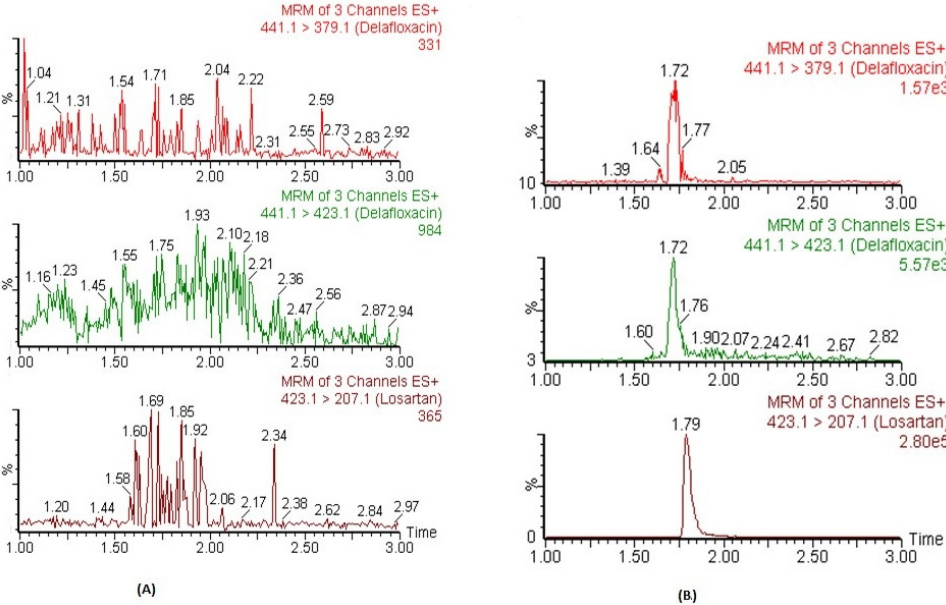
Figure 2. The representative MRM chromatograms of DFX (441.1 → 379.1 for qualifier, 441.1 → 423.1 for quantifier) and IS in blank human plasma ( A ) and plasma spiked at LLOQ level ( B ).